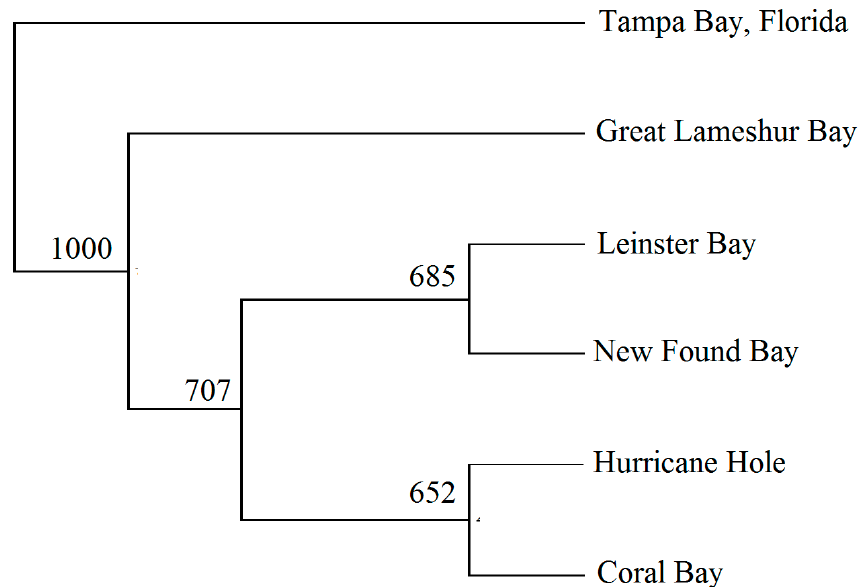
Figure 2. Rooted, neighbor-joining cladogram, illustrating the relationship among the five mangrove populations from the U.S. Virgin Islands. Reynold’s genetic distance. The outgroup employed was an R. mangle population from Tampa Bay, Florida. 1000 bootstraps were performed.